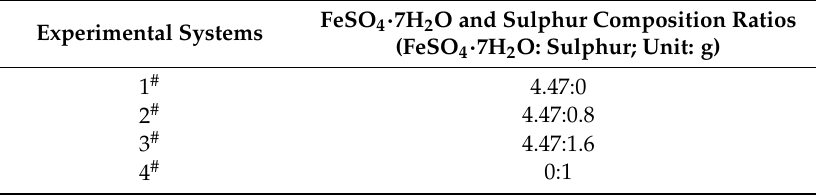
Table 1. The composition of energy source in experimental systems. Experimental